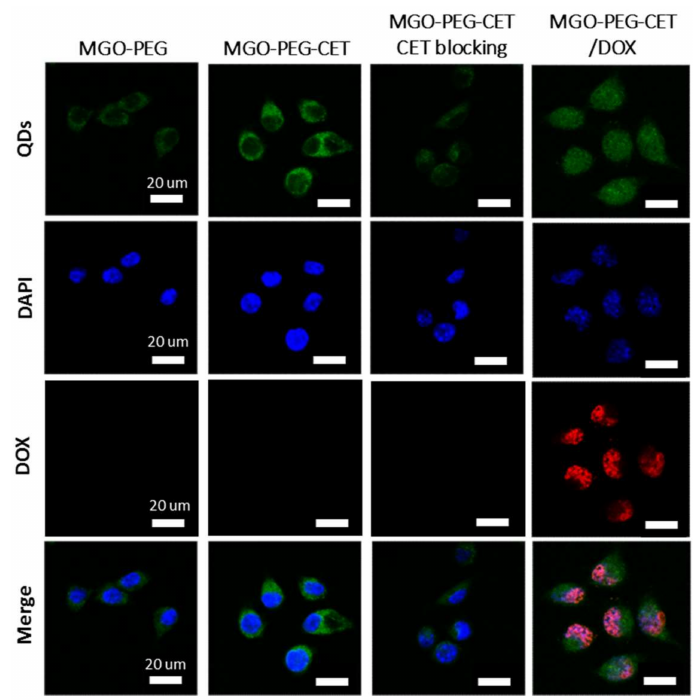
Figure 5. The confocal microscopy images of CT-26 cells after incubated with MGO-PEG, MGO-PEG-CET or MGO-PEG-CET/DOX for 1 h. Blocking of interaction between EGFR and CET (MGO-PEG-CET CET blocking) was carried out by pre-incubating CT-26 cells with CET (1 mg /mL) for 1 h to block EGFR receptors on cell surface followed by incubating with MGO-PEG-CET for 1 h. Bar = 20 µ m.